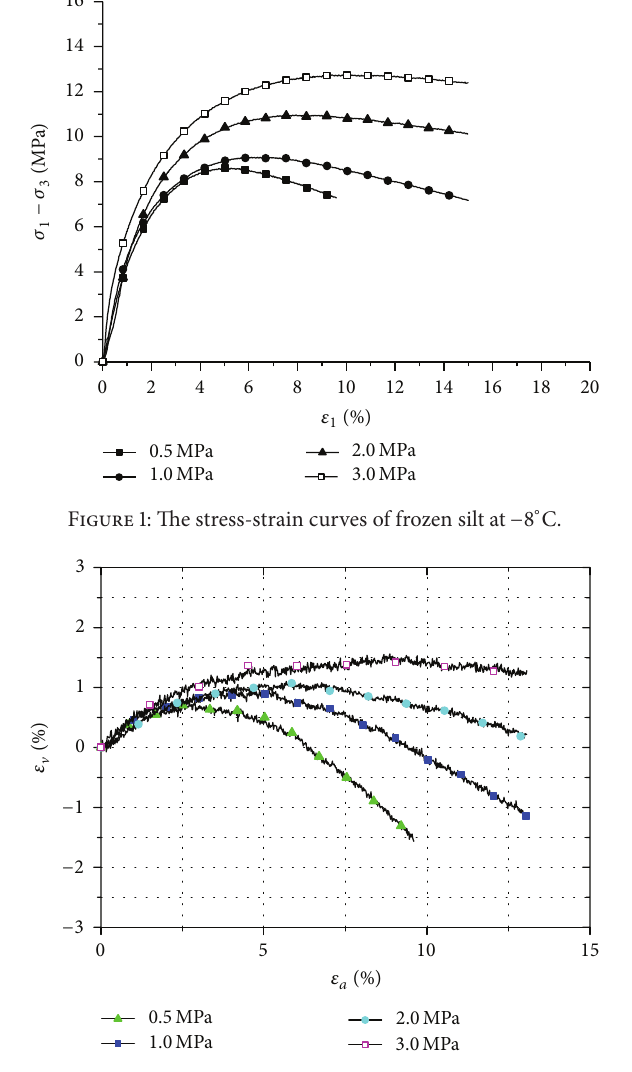
Figure 2: The volumetric strain curves of frozen silt at − 8 ∘ C.